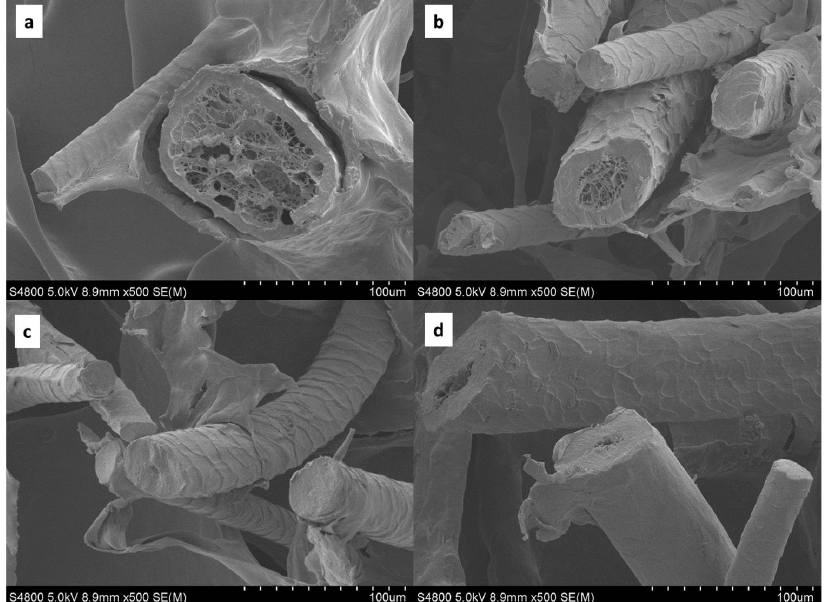
Figure 4. SEM micrographs with magnification of 100 μm for wool/SPI biocomposites: ( a ) SPI7, ( b ) SPI10, ( c ) SPI15, and ( d ) SPI20. Scale bar: 100 μm.